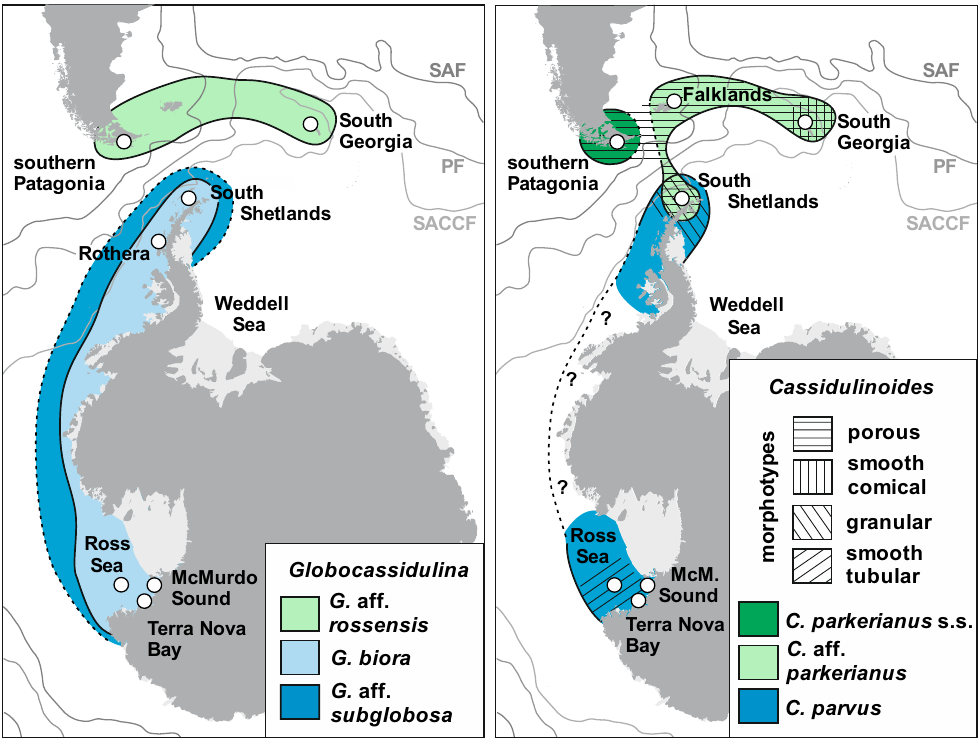
Figure 1. Maps showing sampling localities (white circles) and, in colour, schematically marked ranges of different species of Globocassidulina (left map) and Cassidulinoides (right map), based only on data presented in this paper. For Cassidulinoides , ranges of morphotypes are indicated by different hatching. Map data from https:// freev ector maps. com. Location of the Subantarctic (SAF), Polar (PF), and southern Antarctic Circumpolar Current (SACCF) fronts after 25 .